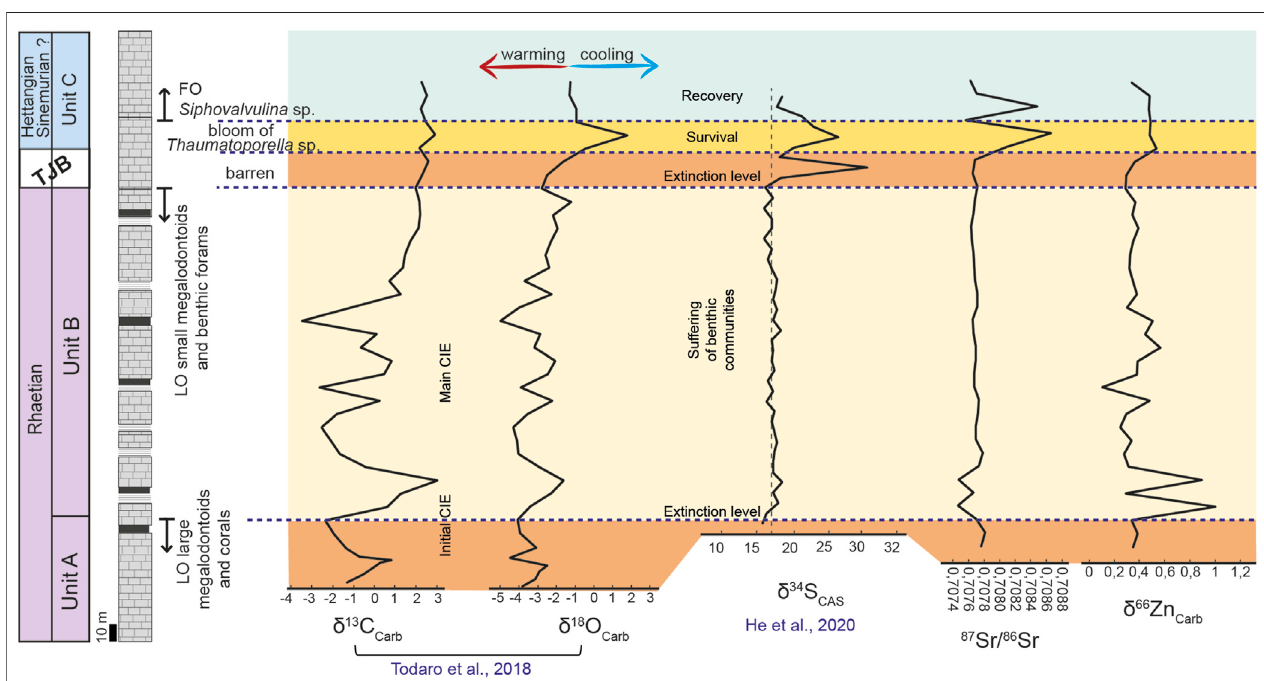
FIGURE 6 | Isotopic curves obtained in the Mt Sparagio section. The trends of the curves indicate environmental perturbations (acidi fi cation, climatic changes, marine anoxia, CAMP-in fl uence) correlated with the two extinction pulses of the benthic community in the Rhaetian horizons. Black intervals represent the supratidal members of the peritidal cycles. The δ 13 C carb and δ 18 O carb are illustrated in Todaro et al. (2018), the δ 34 S CAS curve is after He et al. (2020).